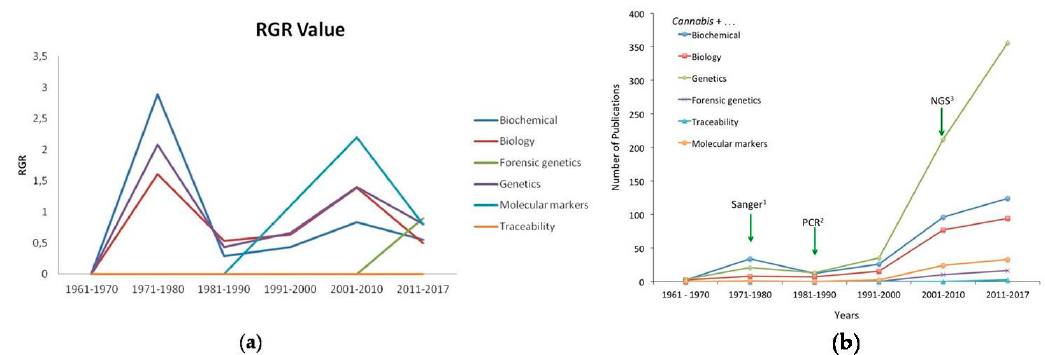
Figure 1. Patterns of publication on Cannabis recovered from the Scopus platform using six different search terms. ( a ) Relative growth rate (RGR) of world’s scientific publications for each search argument. ( b ) Absolute number of publications for each search argument. Three important events related to the development of biotechnological methods are highlighted. 1 In 1977, Fred Sanger [19] described an enzyme-based methodology for DNA sequencing. 2 In 1989, Mullis and Faloona [20] proposed the Polymerase Chain Reaction (PCR) methodology for in vitro DNA amplification. 3 In early 2005, the next-generation sequencing (NGS) was introduced by Life Science through the 454-pyrosequencing methodology.